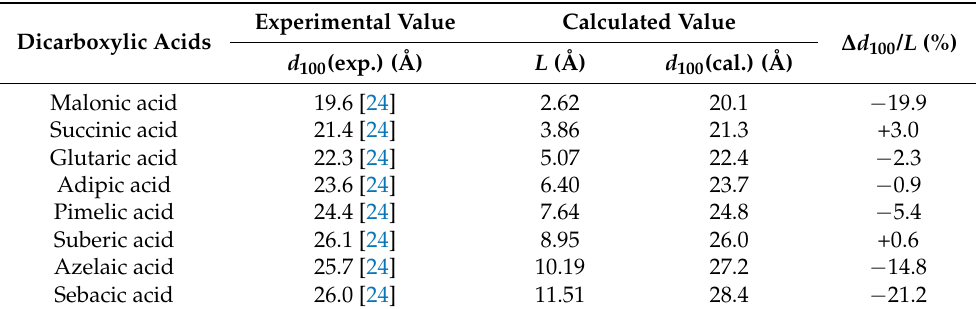
Table 1. Values of d 100 (exp.), L , d 100 (cal.), and ∆ d 100 / L for the ions of aliphatic dicarboxylic acids incorporated in the OCP crystal.